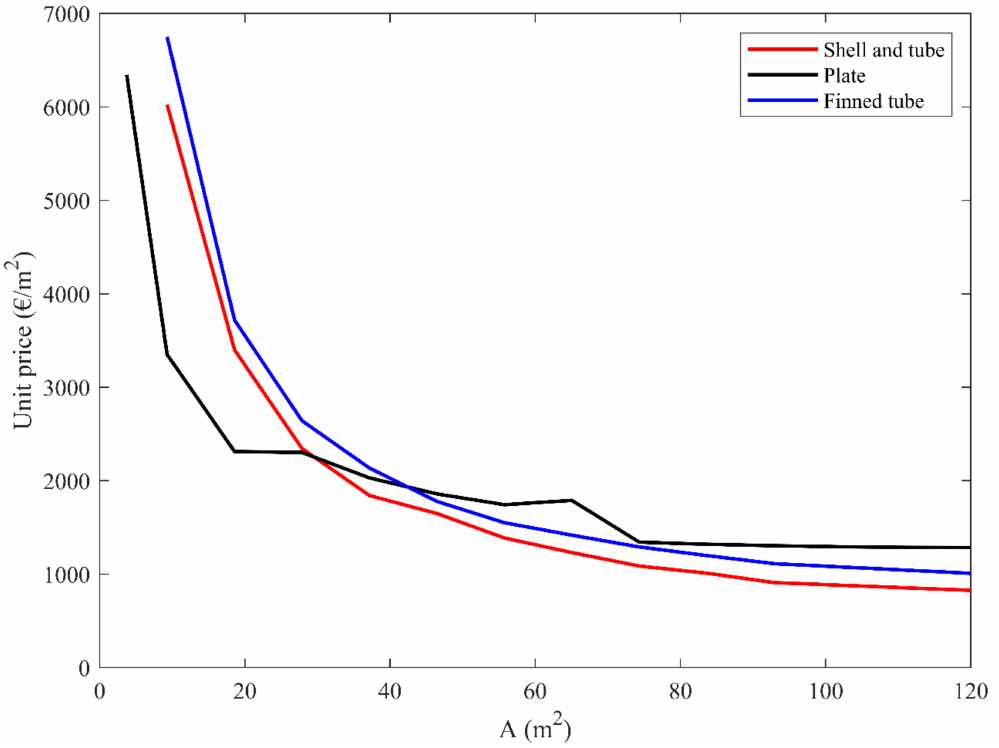
Figure 1. Metal heat exchangers’ (HEXs) unit price as a function of the heat transfer